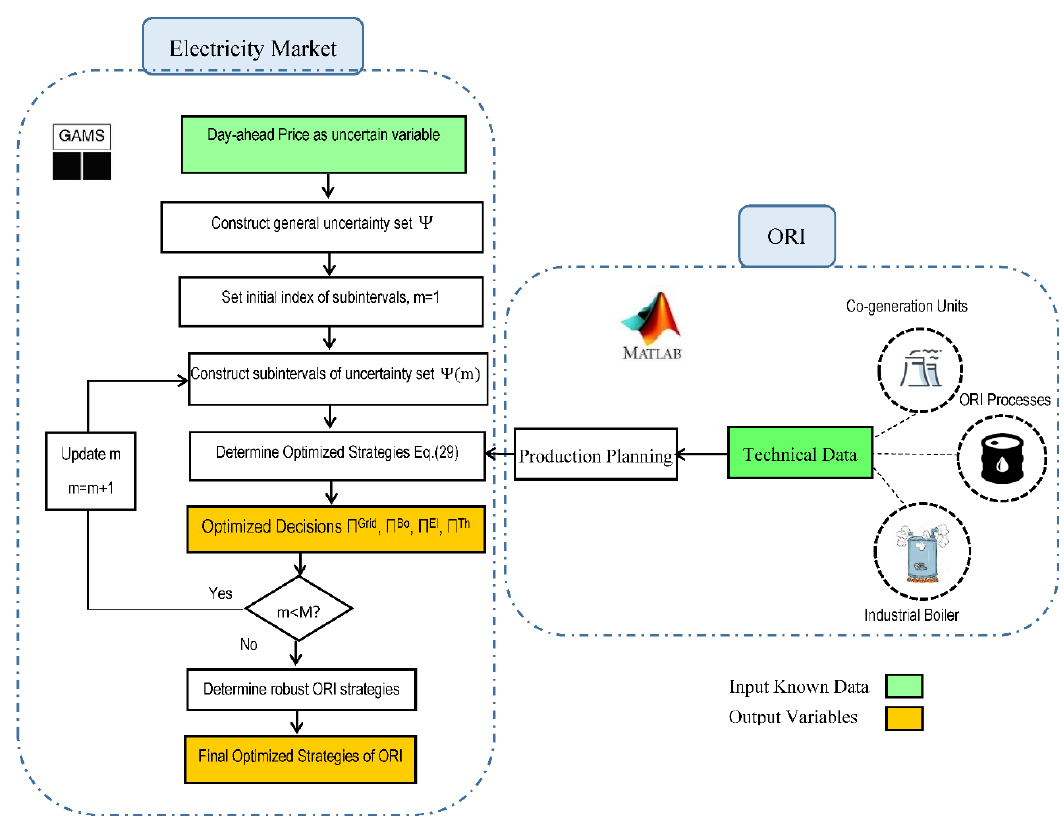
Figure 7. The flowchart of the proposed approach with input and output data.